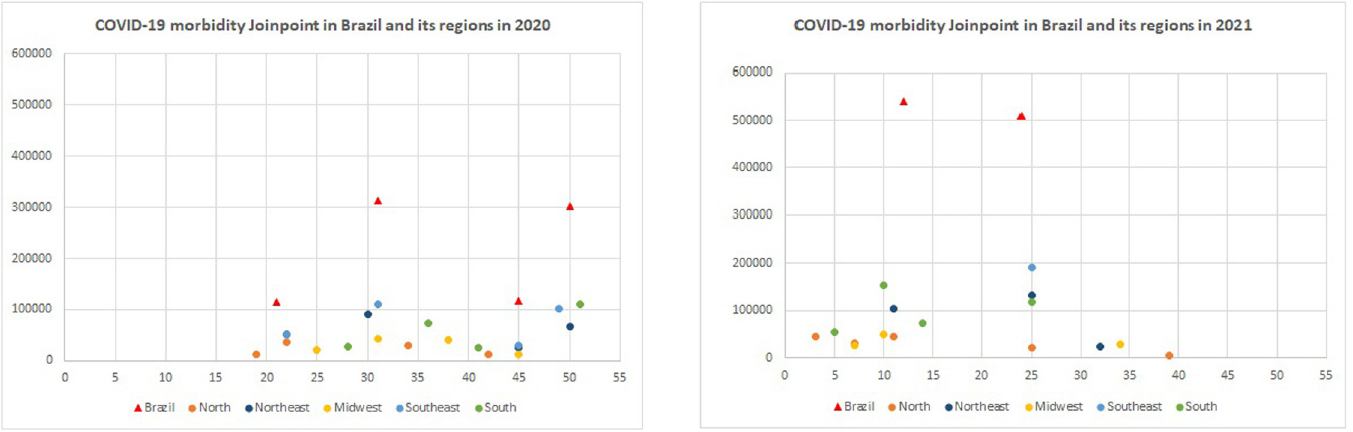
Fig 1. COVID-19 morbidity Joinpoint in Brazil and its regions from 2020 to 2021. Brazil, 2022.